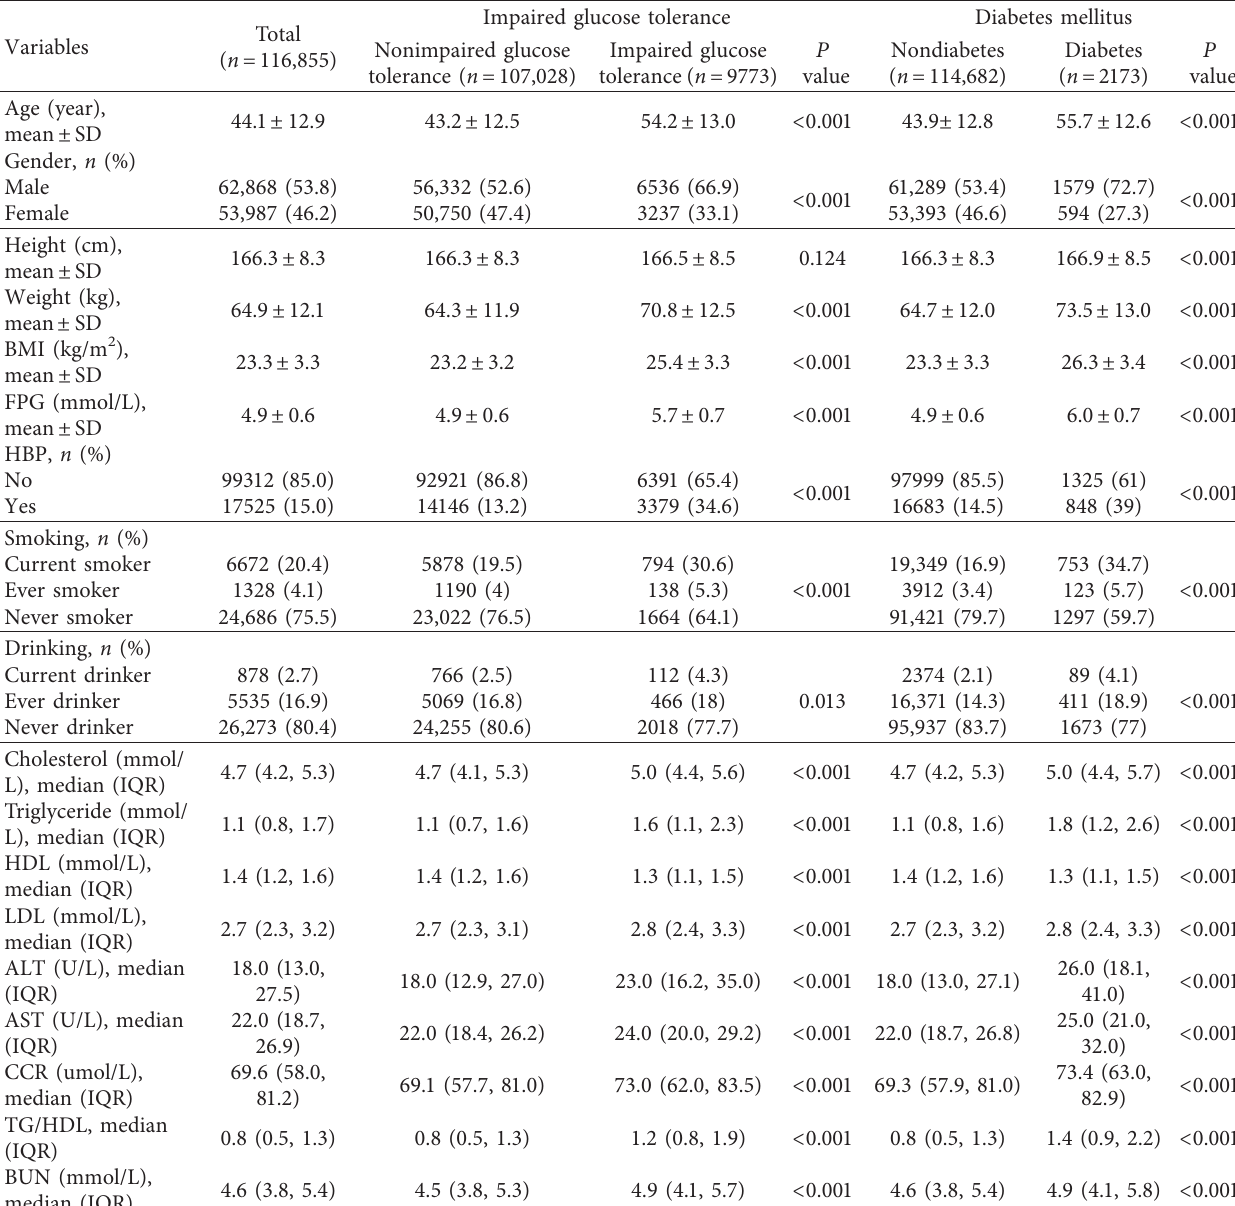
Table 1: Baseline characteristics of the study